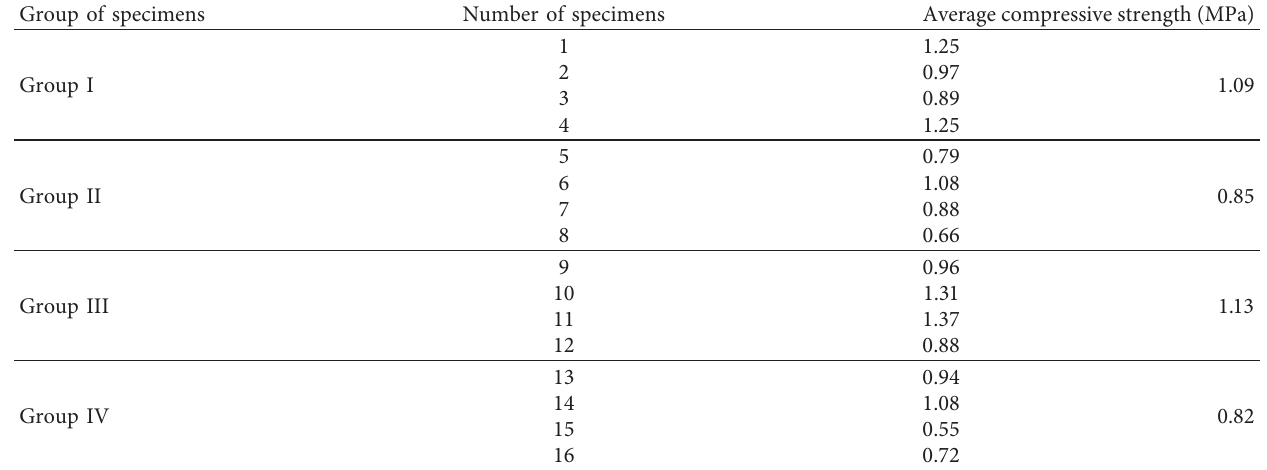
Table 6: Average compressive strength of sand-containing